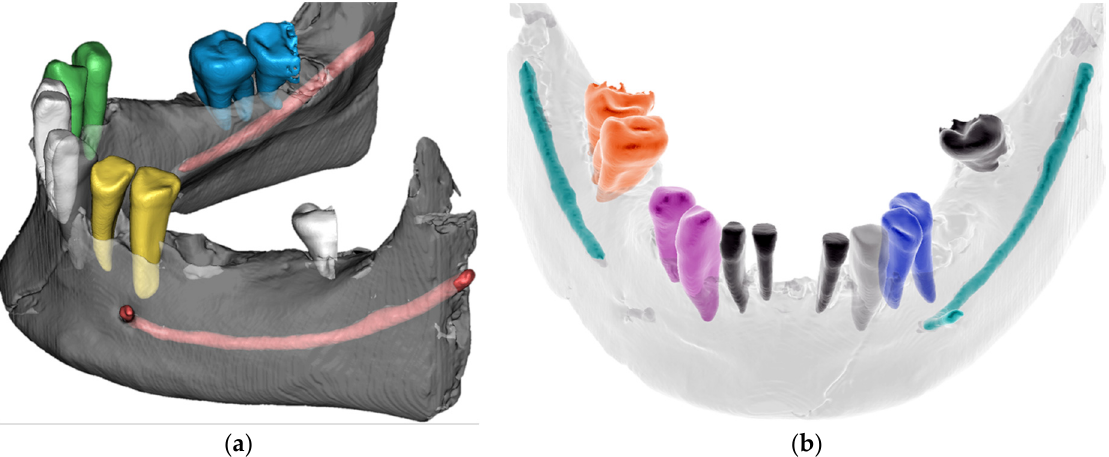
Figure 5. AI-automated segmentation of the mandible with the online tool Diagnocat: ( a ) Separate segments of teeth, bone, and nerve canal can be visualized with distinct colors, opacity and exported as separate STLs. ( b ) Scan of teeth without dental fillings shows unfinished recognition of the right mandibular canal and cut of distal parts of wisdom teeth.